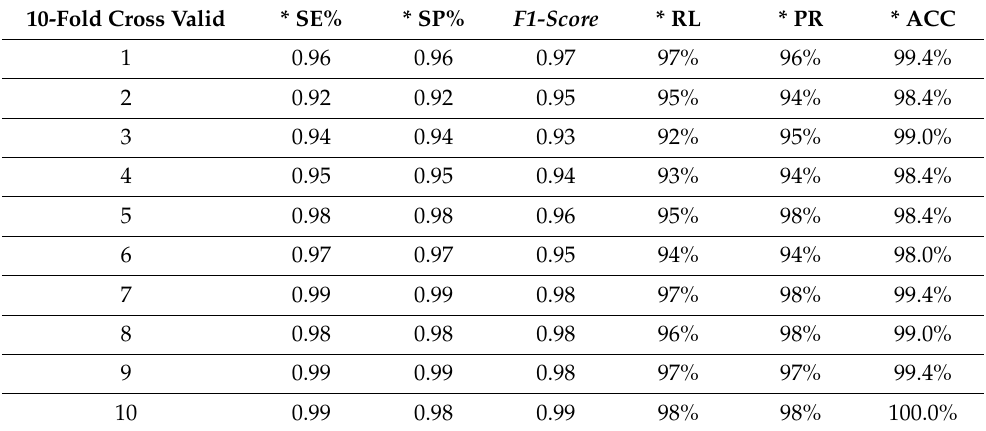
Table 3. Classification results of the Proposed Model by using data augmentation, 10-fold cross validation test and by using five stages of cardiovascular disease. 10-Fold Cross Valid